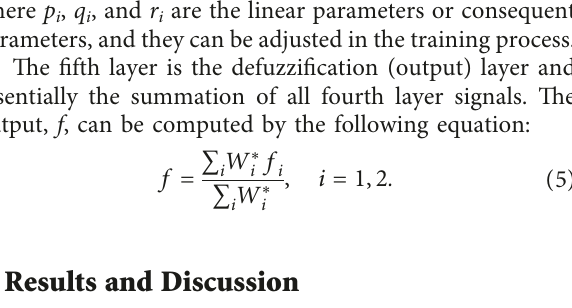
Figure 6: Surface roughness comparison of ablation tracks machined using (a) excimer (sample number 116 line 5) and (b) CO lasers.